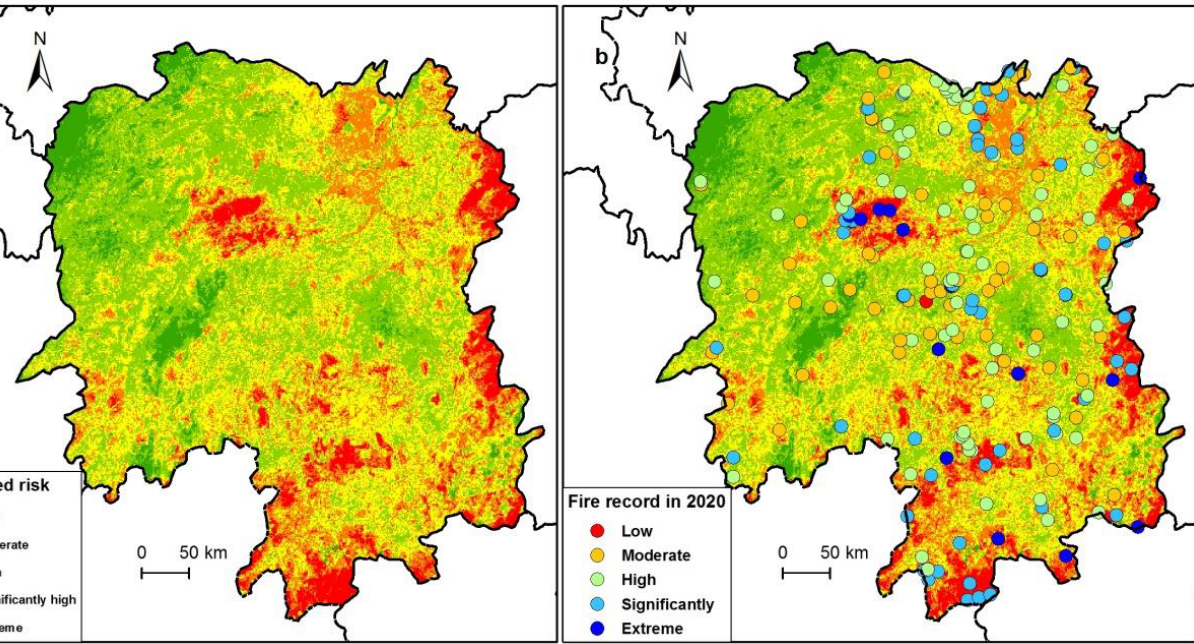
Figure 6. Wildfire: ( a ) hazard zoning, and ( b ) observed in 2020.